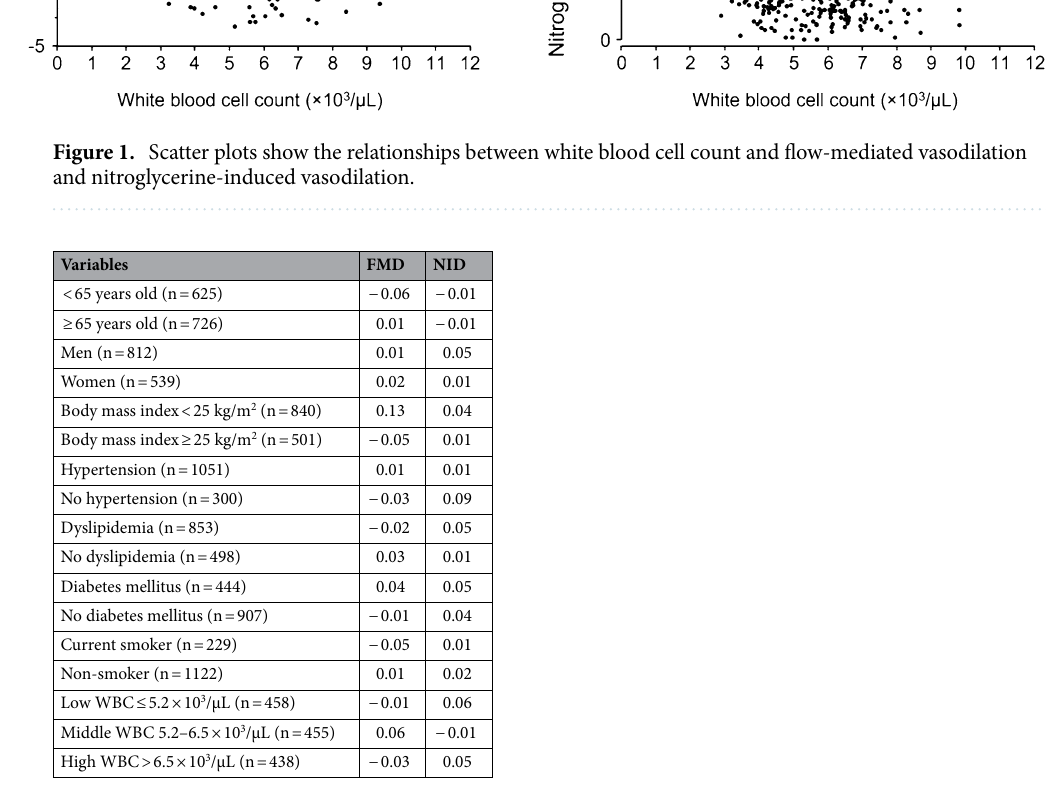
Table 3. Univariate analysis of relationships between white blood cell, FMD and NID in subsets of subjects. FMD flow-mediated vasodilation, NID nitroglycerine-induced vasodilation, WBC white blood cell.